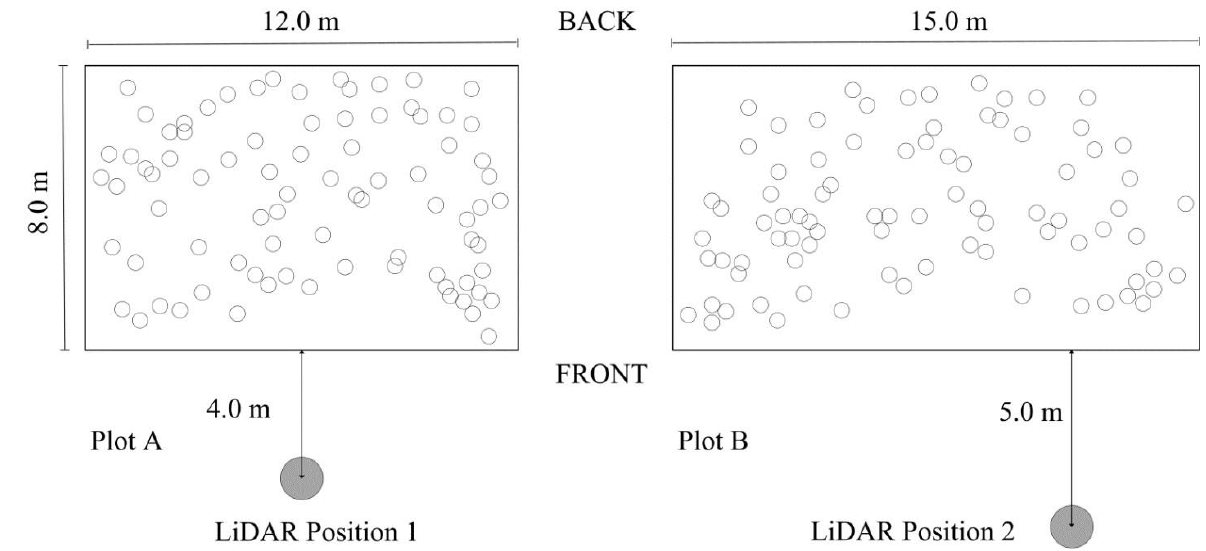
Figure 1. Diagram of two plots. The side near the LiDAR position is defined as front and its opposite is defined as back. Circles indicate relative stem locations.